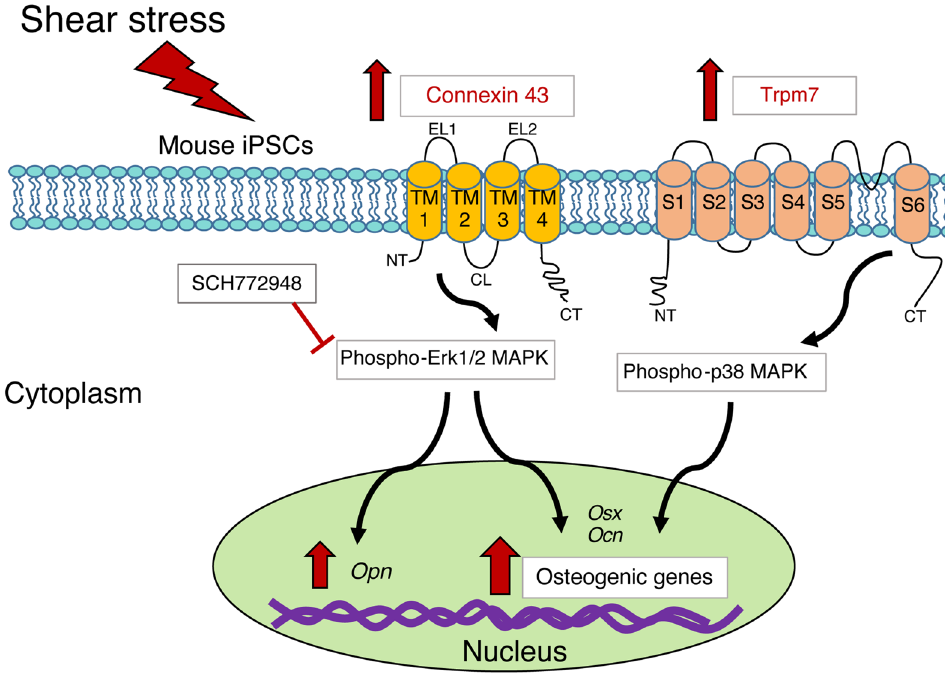
Figure 6. Schematic diagram of shear stress-enhanced osteogenic differentiation of mouse iPSCs and the relevant underlying mechanisms. Shear stress enhanced osteogenic differentiation of mouse iPSCs through Connexin 43 (Cx43) and Erk1/2 signaling. The inhibition of Erk1/2 activity partly suppressed osteogenic gene expression. Trpm7 expression and downstream phosphorylated-p38 were upregulated under shear stress implying that they might be involved in the enhanced osteogenic differentiation of iPSCs by shear